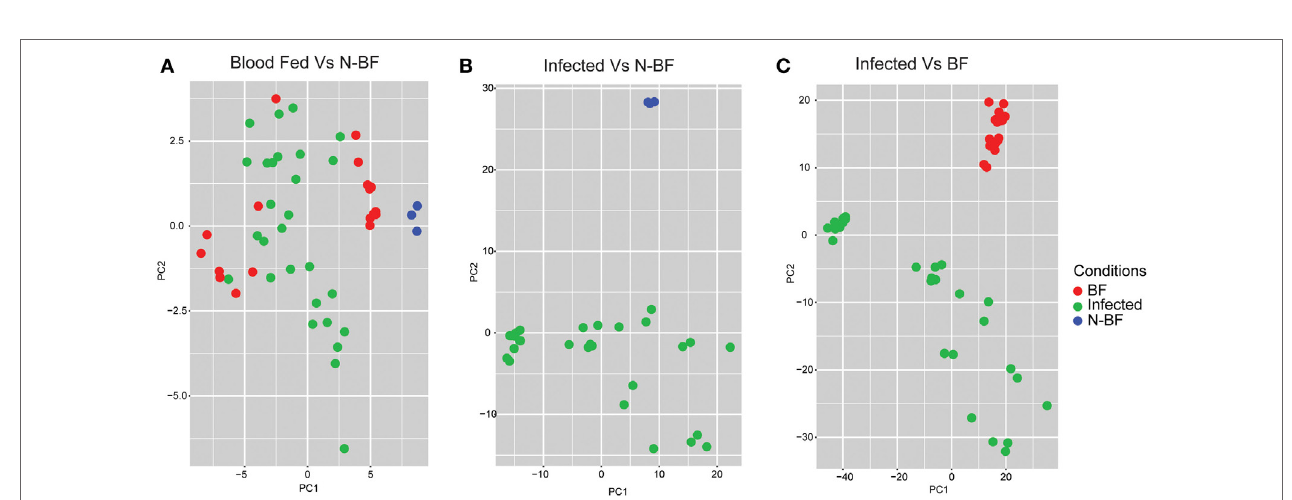
FigUre 3 | Principal component analysis of differentially expressed genes (DEGs). (a) DEGs from the comparison between blood-fed (BF) vs. nonblood-fed (N-BF) did not separate the BF (red), N-BF (blue), and infected (green) groups. (B) DEGs from the comparison of the infected (WNV, YFV, and DENV) vs. N-BF separates the N-BF (red) from the infected (blue) groups. (c) DEGs from the comparison of the infected (WNV, YFV, and DENV) vs. BF mosquitoes separates the BF groups (blue) and infected (red).